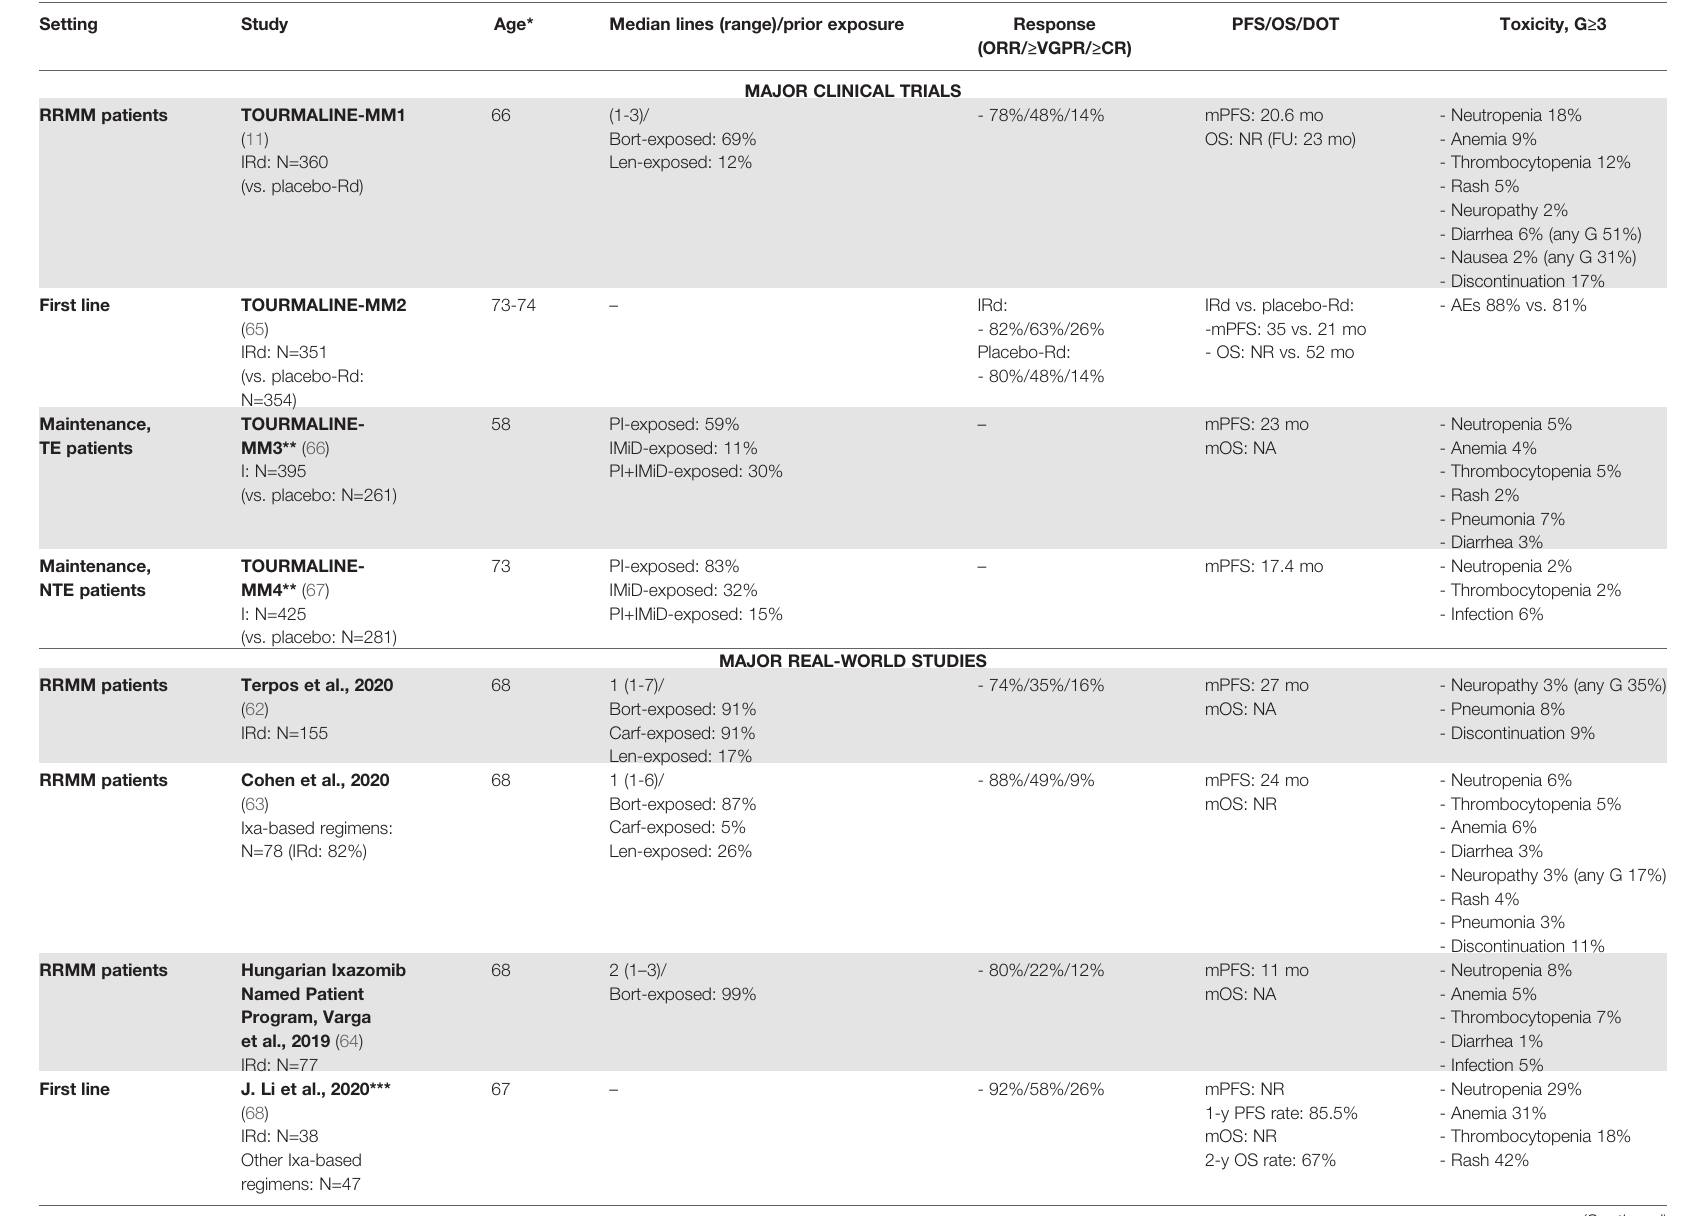
TABLE 4 | Major clinical trials and real-world studies based on ixazomib.